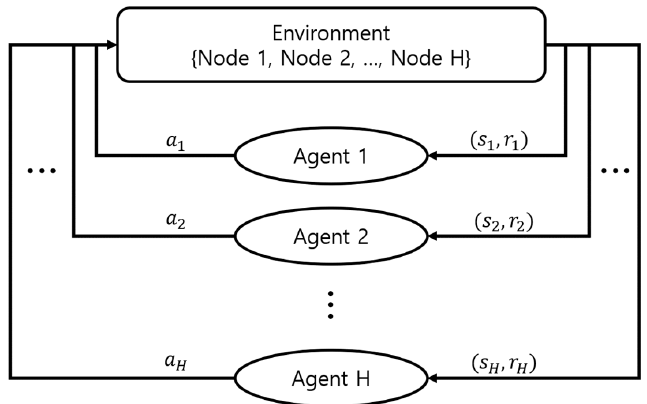
Figure 4. The learning process of MARL in the system.